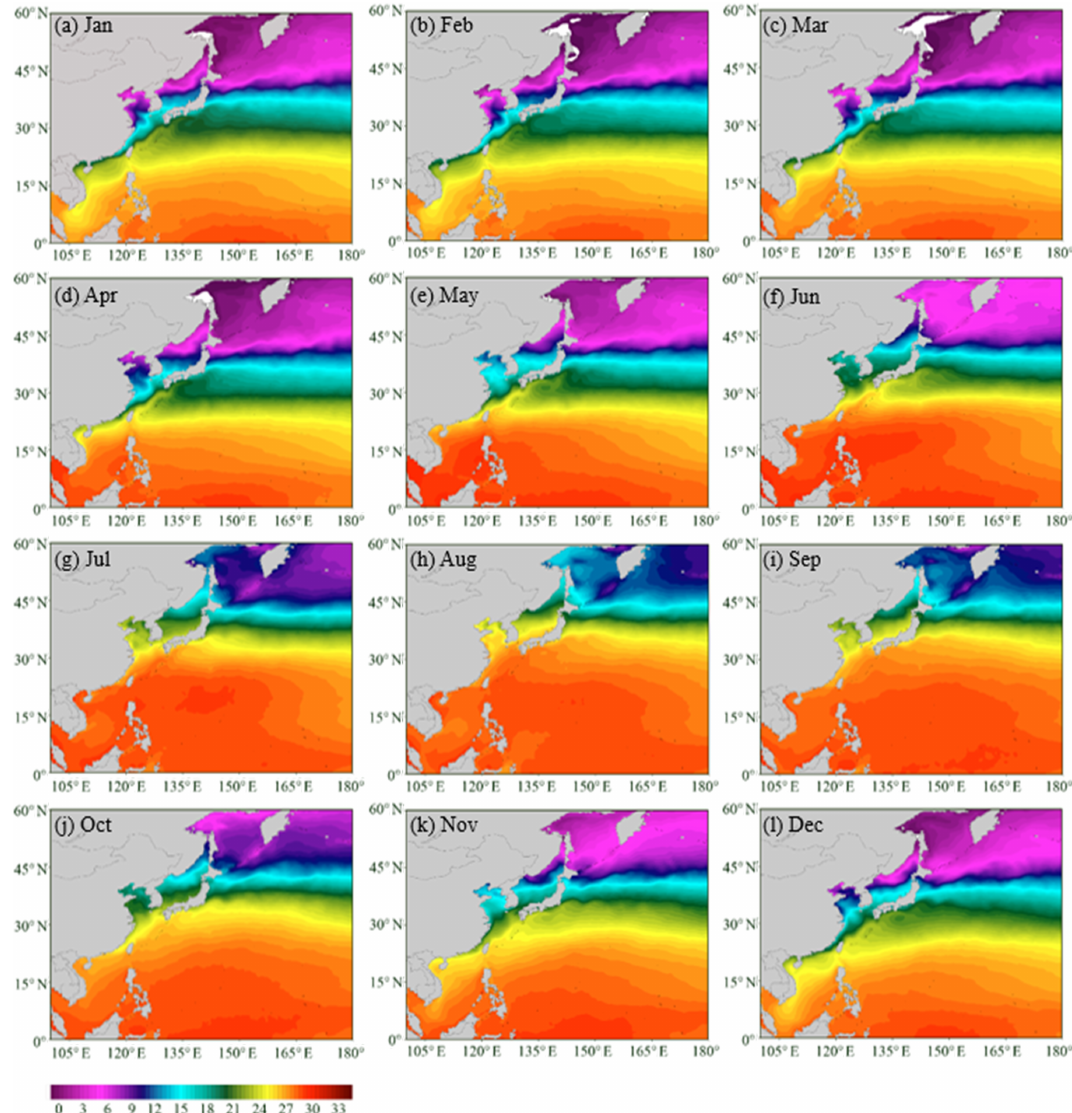
Figure 6. Spatial distribution of monthly SST over the 1988–2017 period.